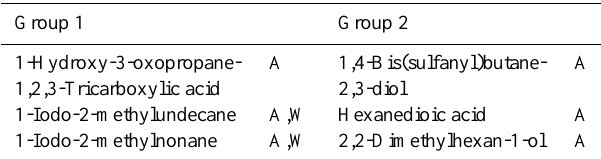
exclusively present in the aerosol particles collected during Figure 6 Wind-induced events during December 2009. Boxes A-D show the particle size 3 event periods. distribution from AIS (negative polarity) as well as wind direction and speed during five days 4 of wind-induced events on December 2009. The colour scale in AIS surface plots is 5 dN/dlogDp. 6